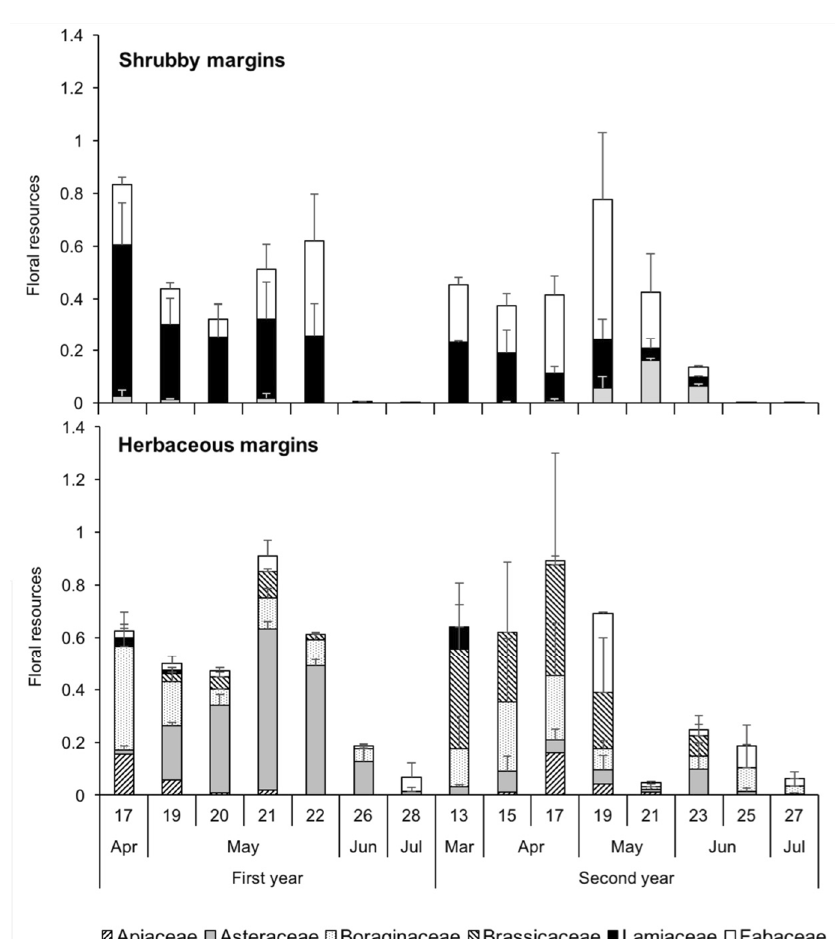
Figure 4. Trends in the floral resources (i.e., the proportion of cover*proportion of the plant in bloom) of di ff erent plant families in shrubby (upper) and herbaceous (lower) margins (means ± SE). The numbers in the abscise (x) axe indicate the week of the year.